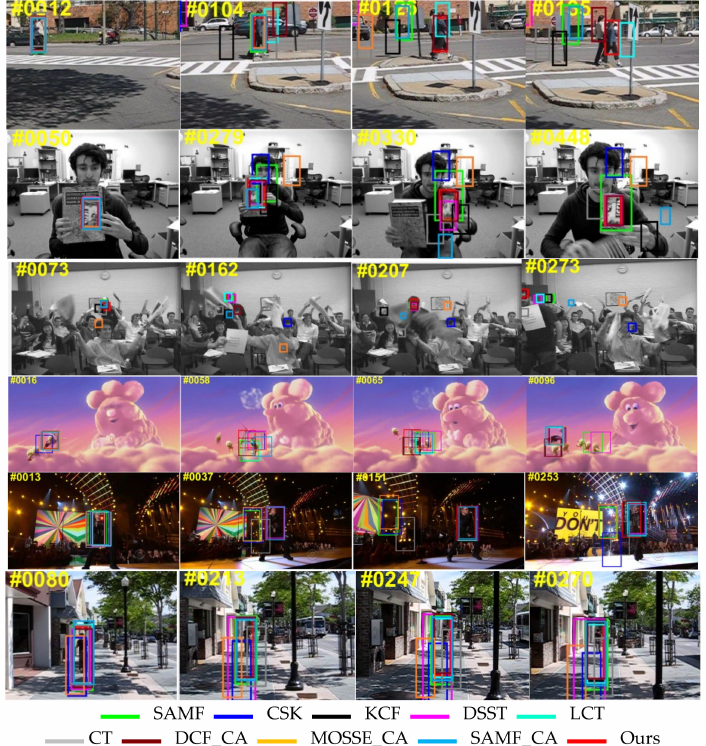
Figure 6. Qualitative comparison of the proposed algorithm with 10 trackers on 6 challenge sequences (from left to right and top to down are Couple , ClifBar , Freeman4 , Bird2 , Singer2 , Human9 ). Notation: We denotes F − 1 as the inverse Fourier transformation, and use a hat ˆ as shorthand for the DFT of a vector. The symbol * denotes conjugate operation, and the fraction denotes element-wise division. The bar G, F, and A represent complex conjugation and the product GF l is point-wise. The symbol (cid:12) denotes the convolution